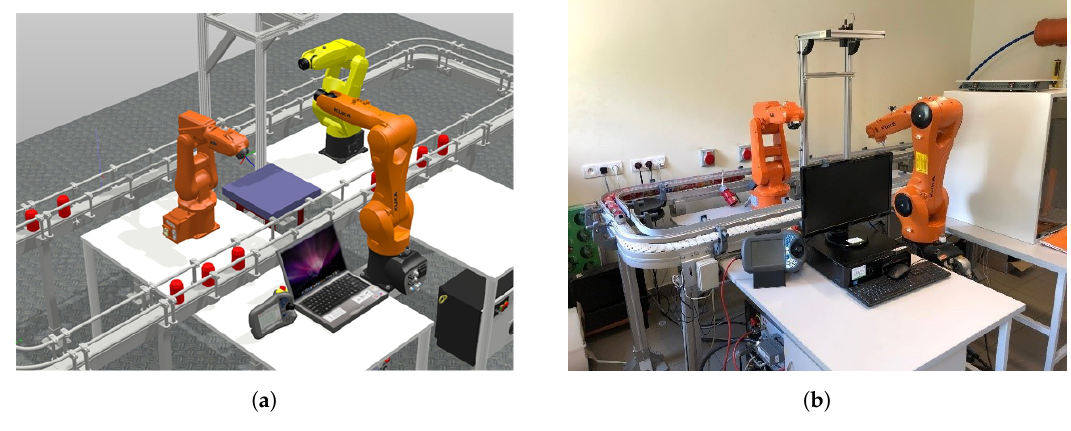
Figure 4. General view of the robotised station: ( a ) virtual; ( b )